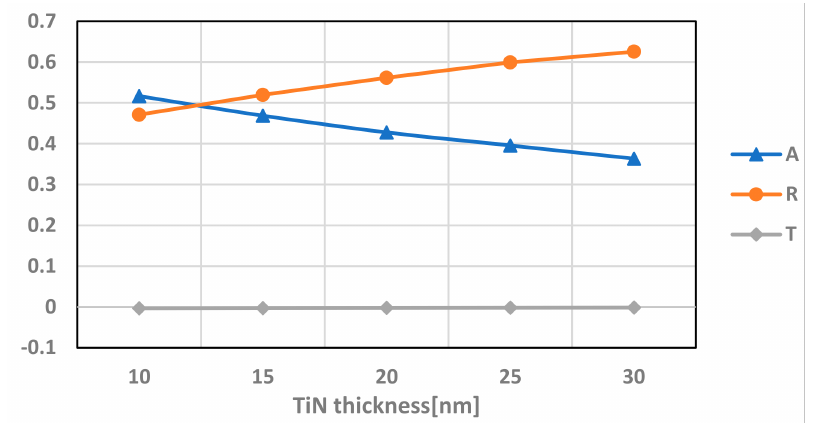
Figure 9. Absorption (A), reflection (R), and transmission (T) of the transistor with varying thick- nesses of the TiN layer. Simulation is performed at 9.5 µ m